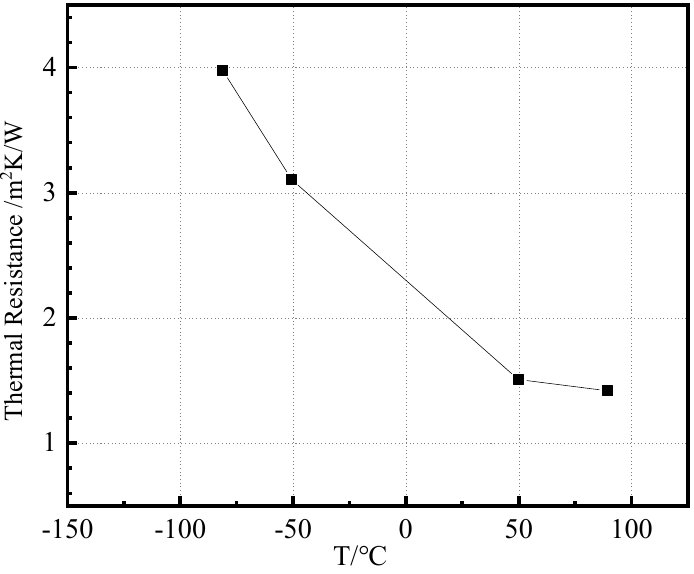
Figure 11. Thermal resistance of the new material (temperature difference of 30 K, compression thickness of 2 mm, and vacuum of about a 0.001 Pa magnitude).